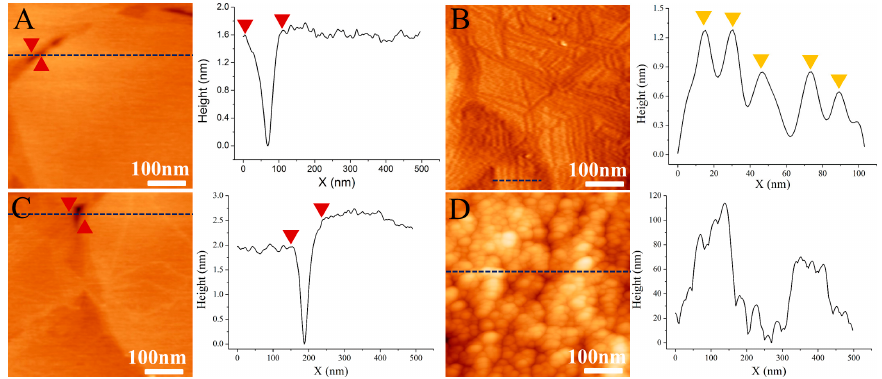
Figure 5. AFM images of ( A ) bare gold surface, and the surface morphology of the substrate ( B ) after direct detection of PrP Sc /BSA, ( C ) after the detection of the purified sample and ( D ) after the detection of the released AMNPs labeled PrP Sc .